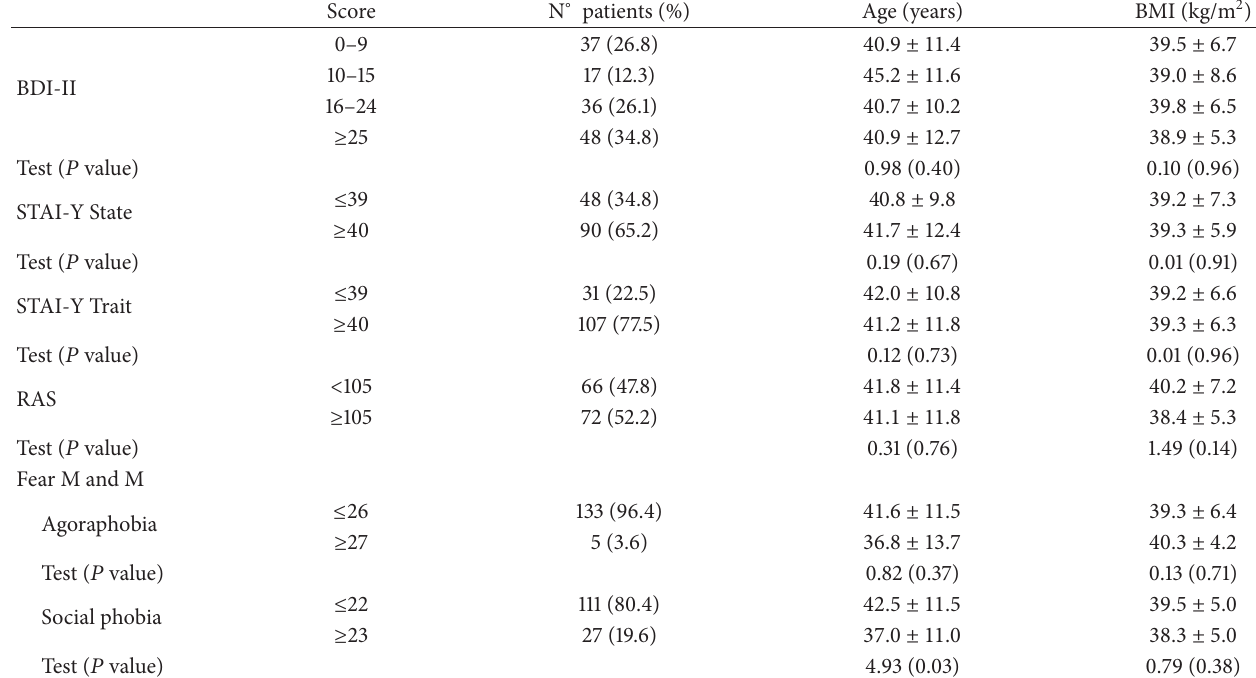
Table 1: Distribution and characteristics of patients according to psychological profile.